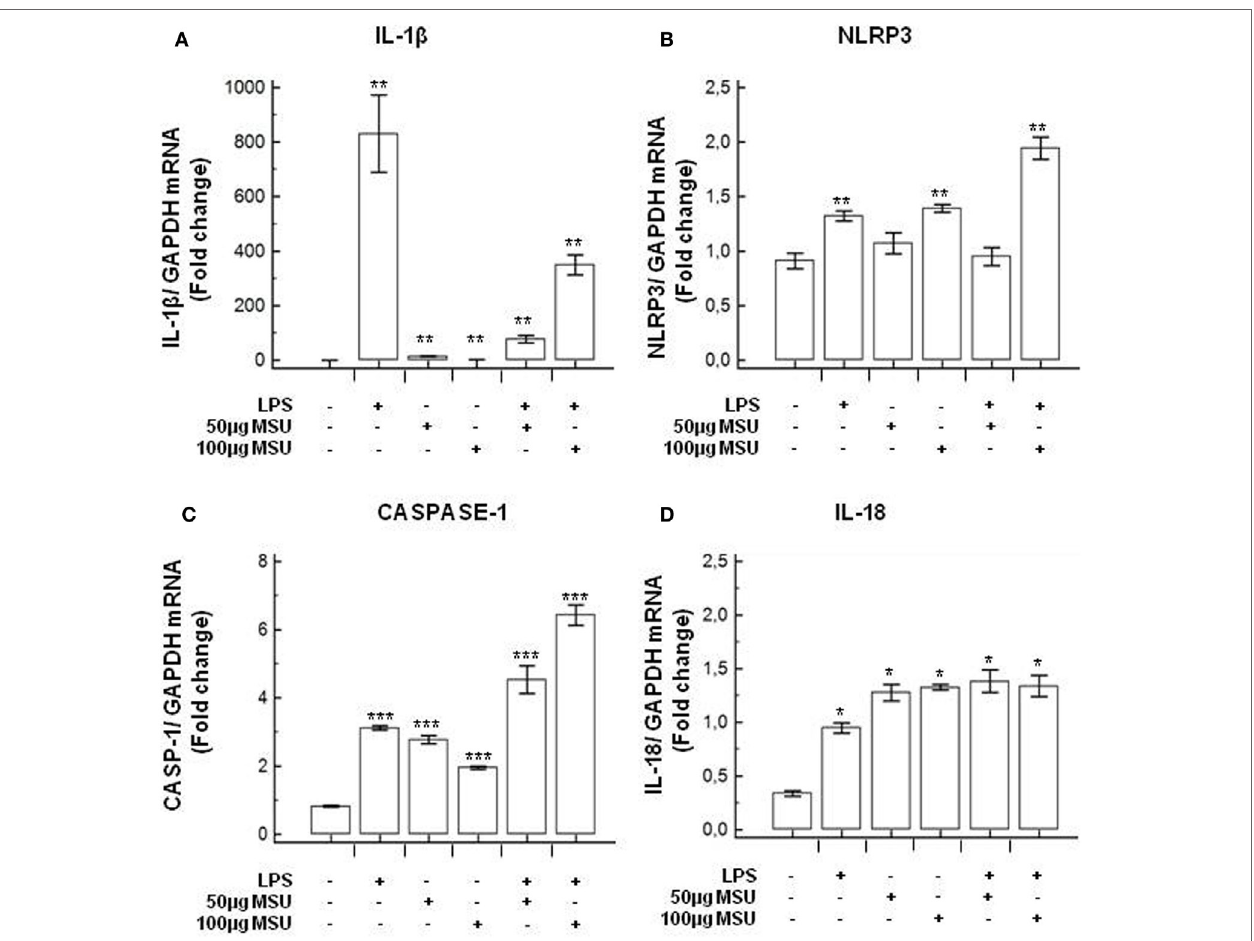
FigUre 2 | Modulation of inflammasome genes by monosodium urate crystals (MSU) in THP1 cells. THP-1 cells were treated with lipopolysaccharide (LPS) (1 µg/ ml) for 2 h and/or with the indicate concentration of MSU crystals for 22 h. RNA was isolated from THP-1 cells and the level of IL-1 β (a) , Nod-like receptor protein 3 (NLRP3) (B) , Caspase-1 (c) , and IL-18 (D) transcription was determined using SYBR green qPCR. Human GAPDH was used for normalization.